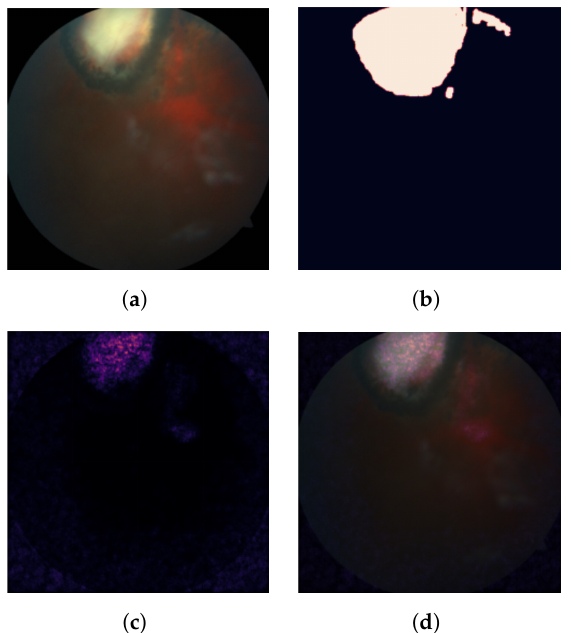
Figure 7. An example of an unhealthy eye fundus image that was correctly classified by the CNN model ( a ), the mask segmented by an ophthalmologist ( b ), a heatmap of the IG-based pixel attribution scores ( c ) and the attribution scores as an overlay ( d ). Median pixel attribution score differences were statistically significant between lesion and non-lesion areas.